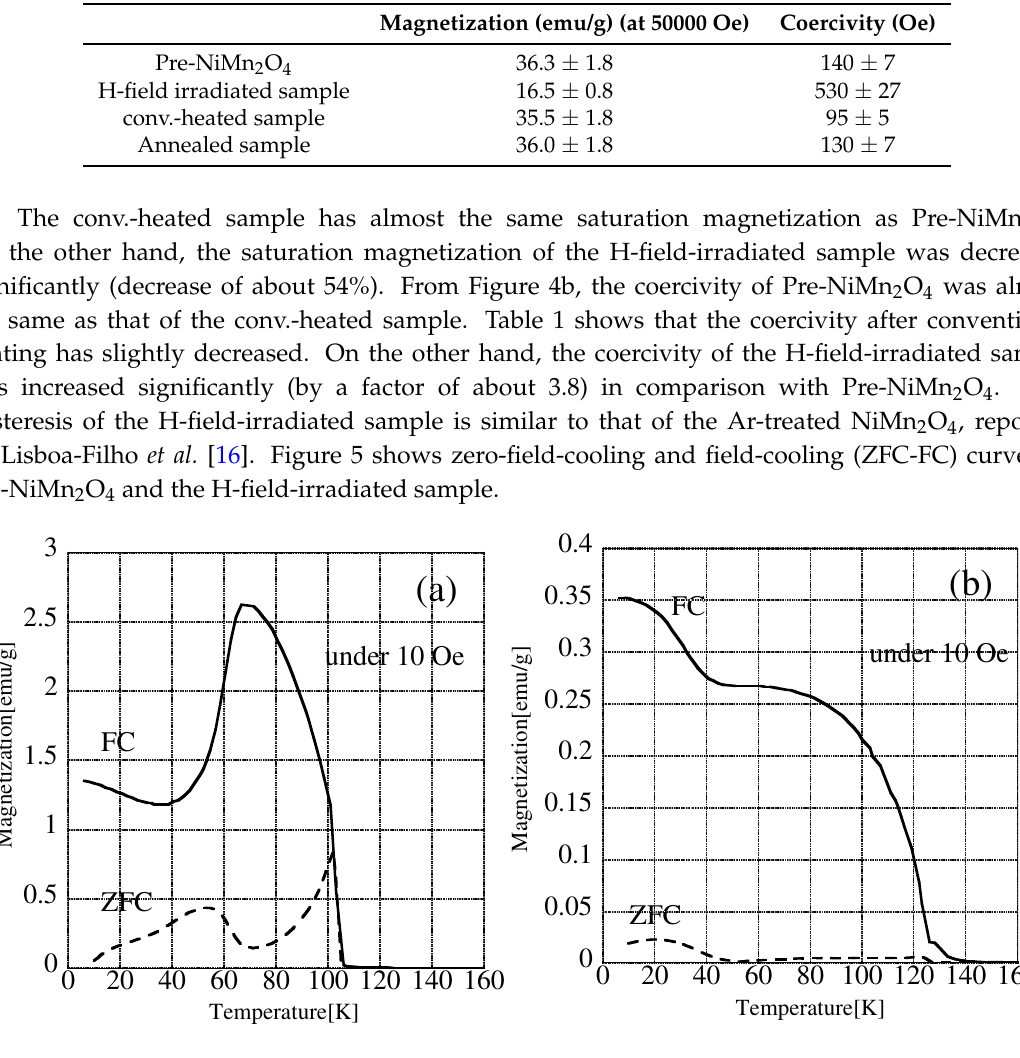
Figure 5. ZFC-FC curves of NiMn 2 O 4 . ( a ) Pre-NiMn 2 O 4 and ( b ) H-field-irradiated sample (850 ◦ C, 10